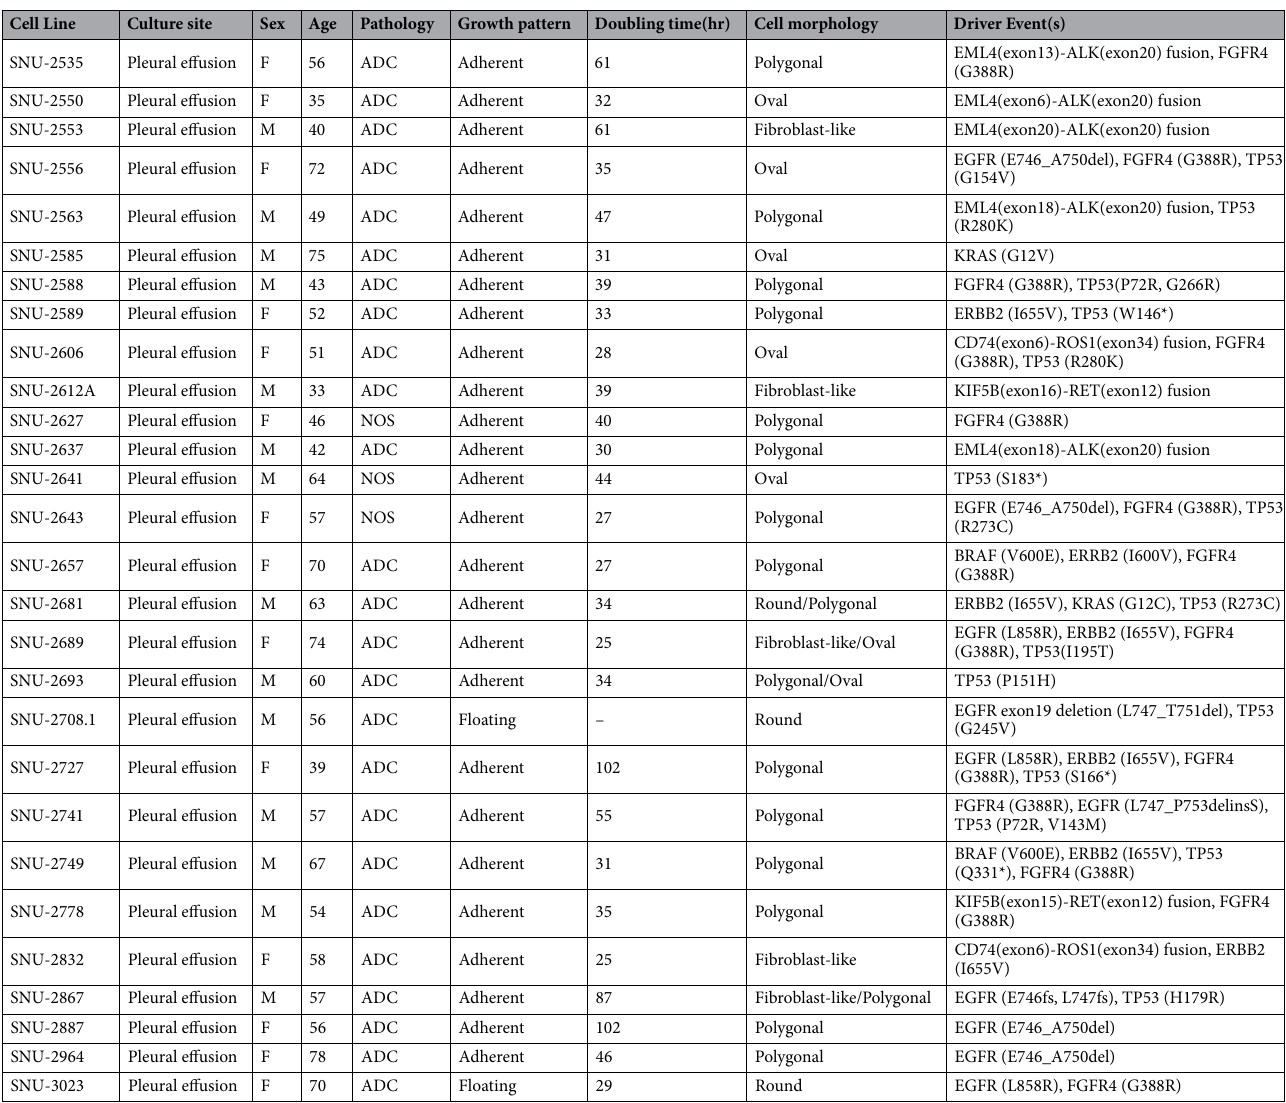
Table 1. Clinicopathological features of 28 human lung cancer cell lines. ADC indicates adenocarcinoma, NOS indicates not otherwise